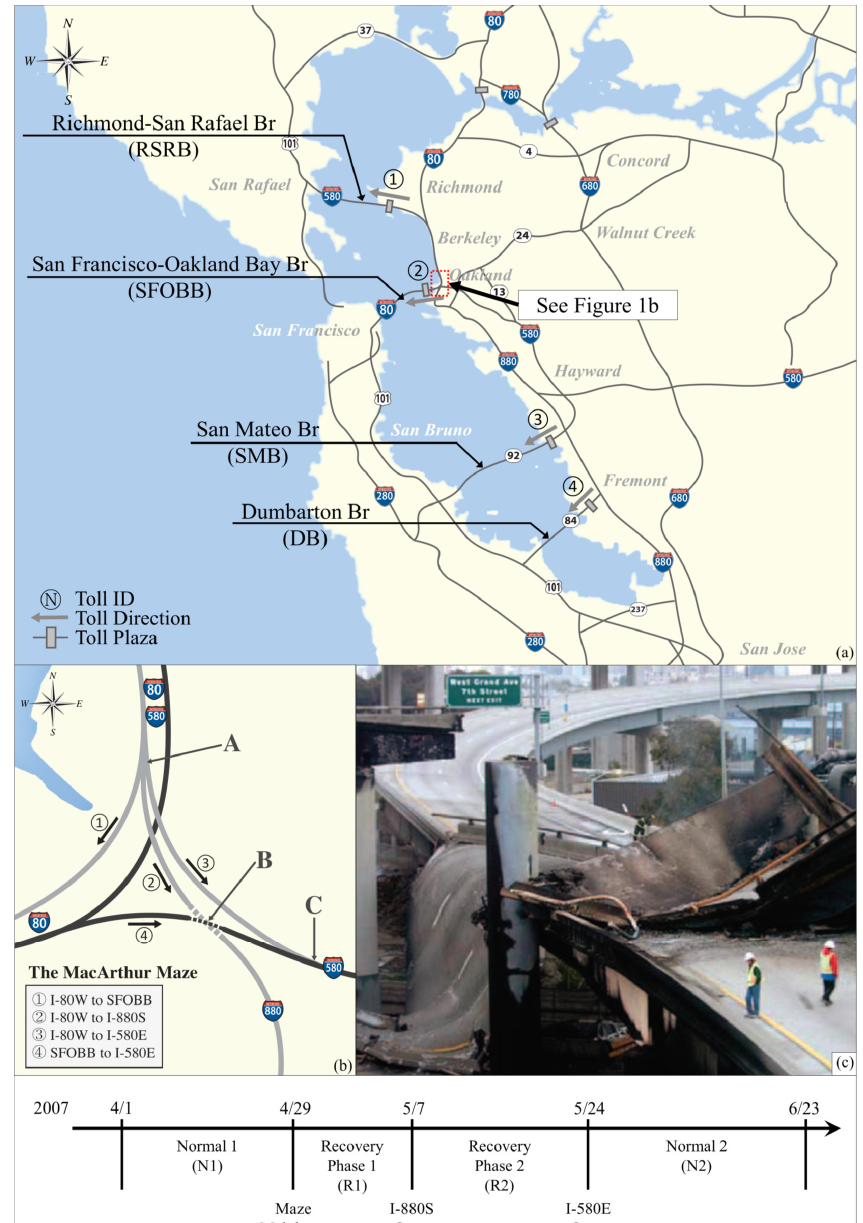
Figure 1. ( a ) Map of the San Francisco Bay Area, California; ( b ) map of the MacArthur Maze; ( c